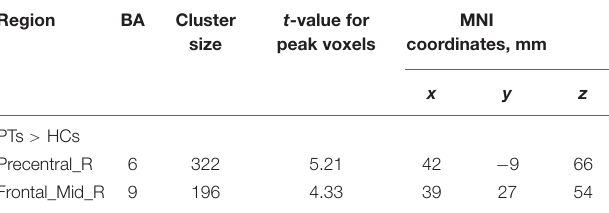
TABLE 4 | Brain regions showing significant ReHo differences between CAI patients and healthy controls. Region